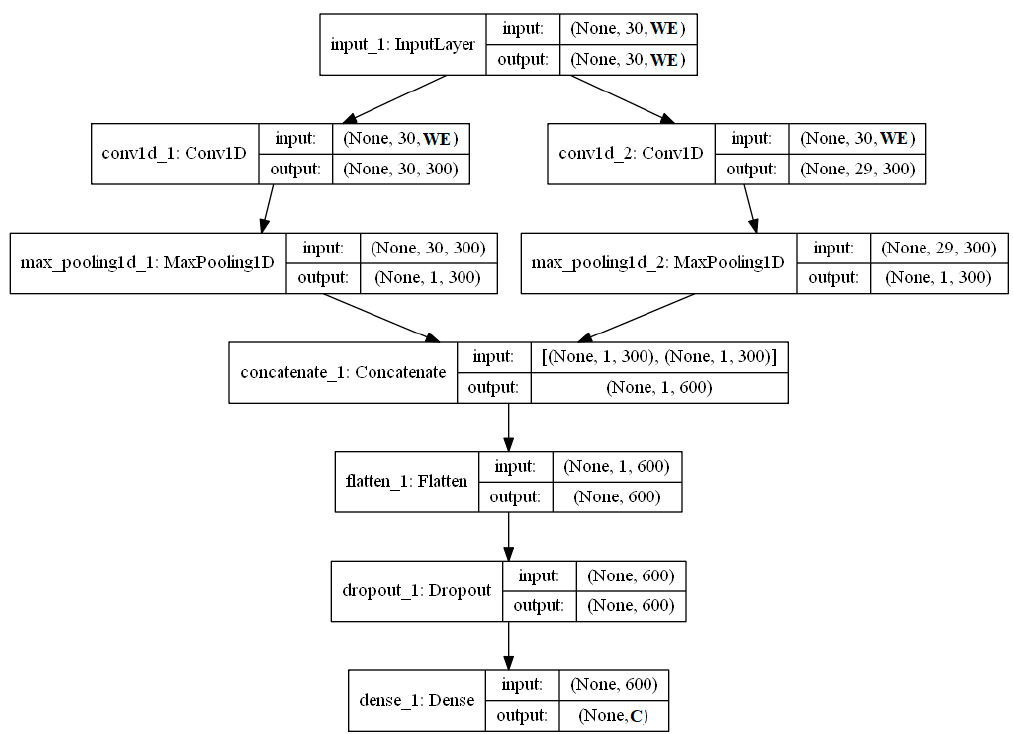
Figure 3. The optimal convolutional neural network (CNN) model architecture. Appl. Sci. 2020 , 10 , x FOR PEER REVIEW